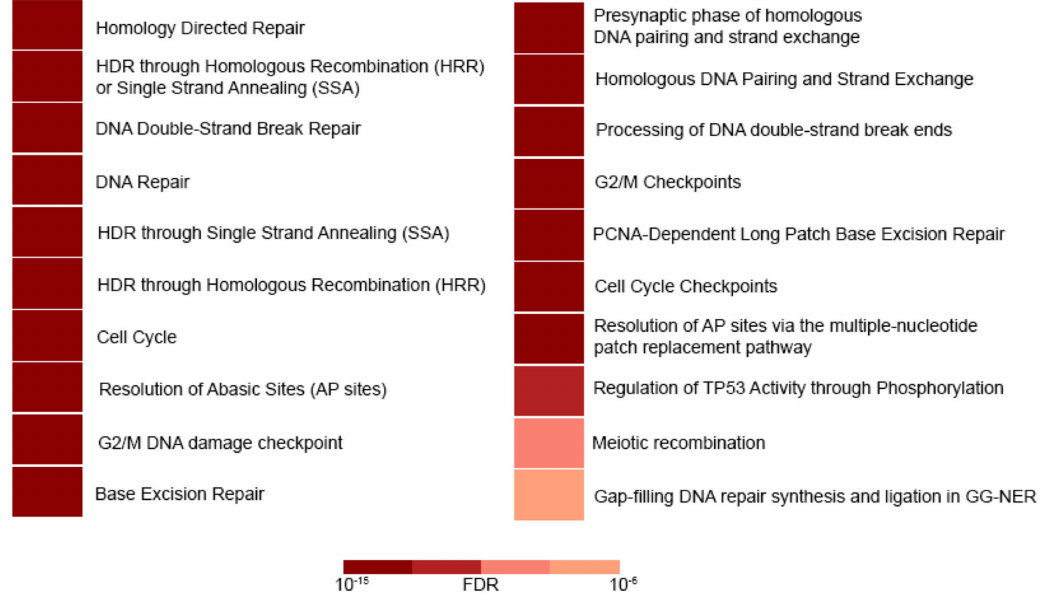
Figure 3. Reactome pathway enrichment analysis [45]. Deregulated genes in cells that overexpress miR-27b-3p act mainly in DSB repair through HRR and other closely related processes. Most of them enriched processes, including the 27 deregulated genes observed in the miR-27b-3p overexpressing cells. Color intensities are representatives of false discovery rate values